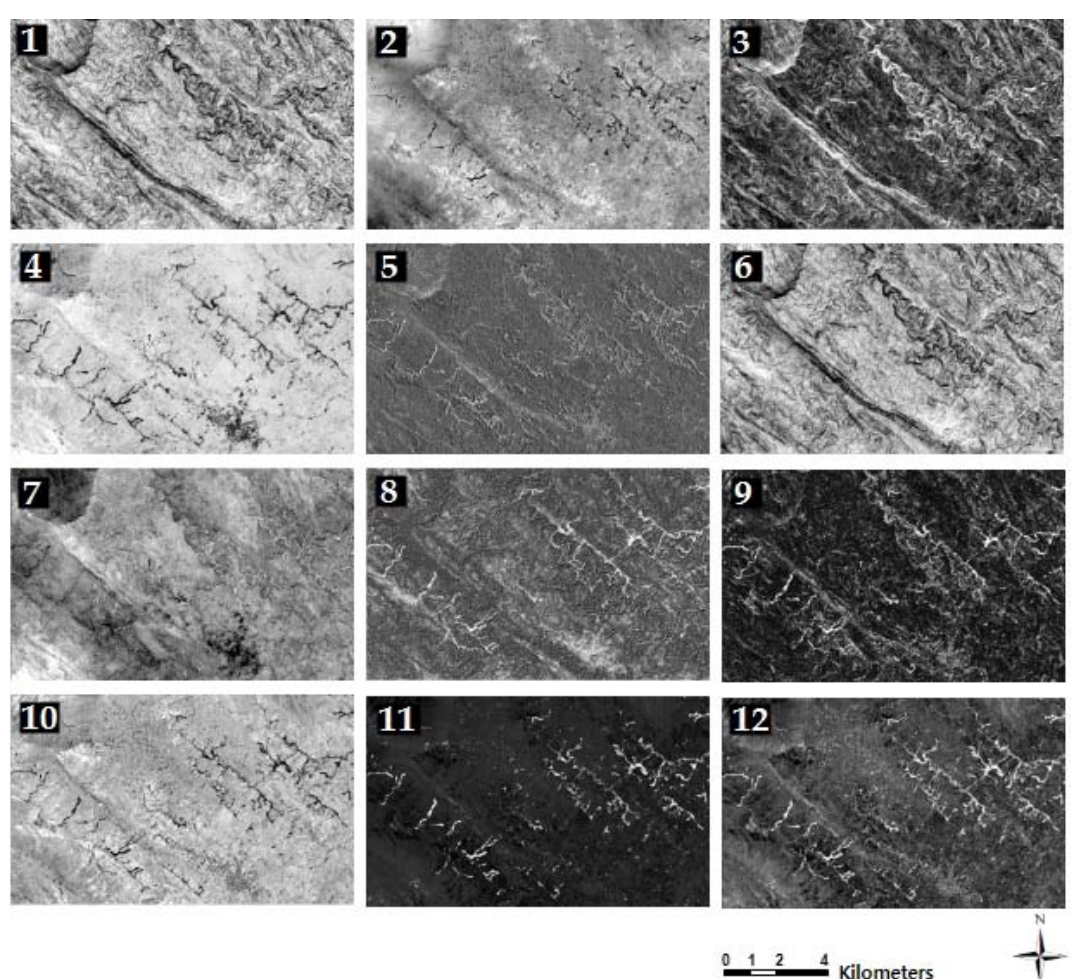
Figure 8. Reconstructed deep features of India’s case study. The stack of MNF features, slope, and NDVI layers were fed to our optimized CAE model (optimal parameters achieved in the tuning process), and the model’s outputs were 12 reconstructed features of the input